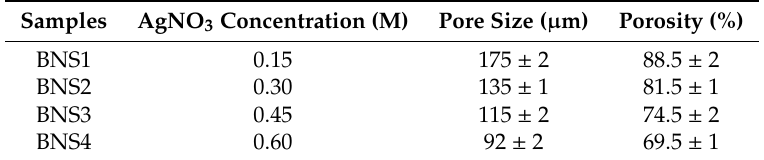
Table 1. Composition of the bioactive nanocomposite sca ff olds, their respective porosity, and pore size.